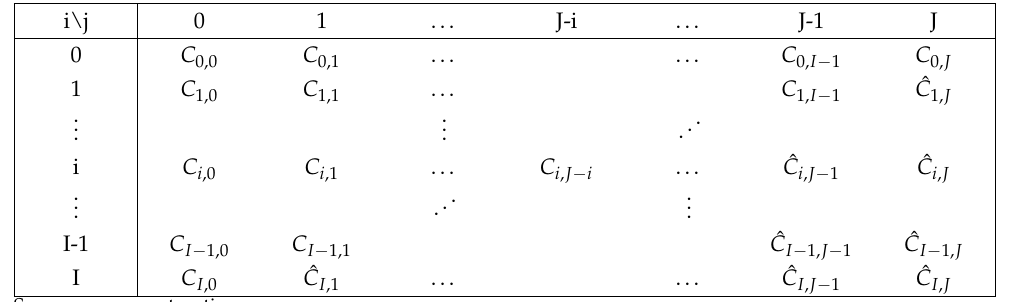
Table 2. Completed lower triangle.